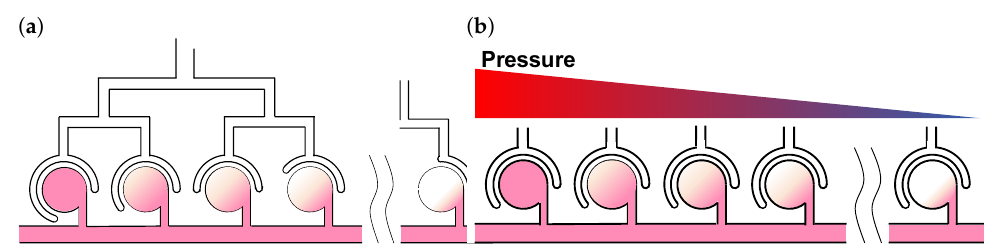
Figure A1. How to generate concentration gradient by outer-circumference-driven on-chip mixer. ( a ) Generation of concentration gradient by enclosure angle. Flow path was designed so that all driving chambers were equally pressurized, and the concentration was adjusted by enclosure angle. ( b ) Generation of concentration gradient by pressure gradient. All driving chambers had the same enclosure angle, and the concentration gradient was generated by the pressure supplied to the driving